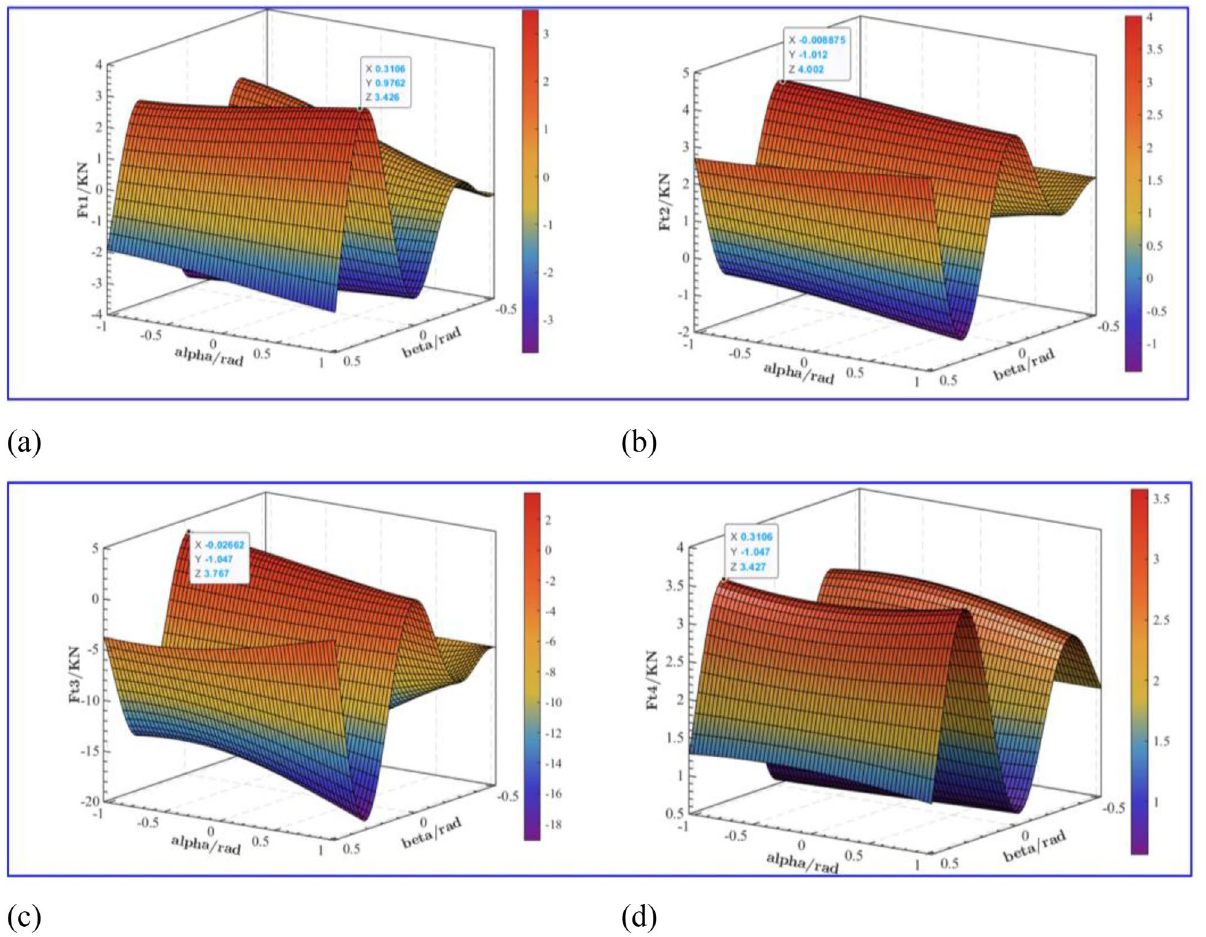
Figure 7. Support force changes with drilling angle: ( a ) F t1 variation with Drilling Angle; ( b ) F t2 variation with Drilling Angle; ( c ) F t3 variation with Drilling Angle; ( d ) F t4 variation with Drilling